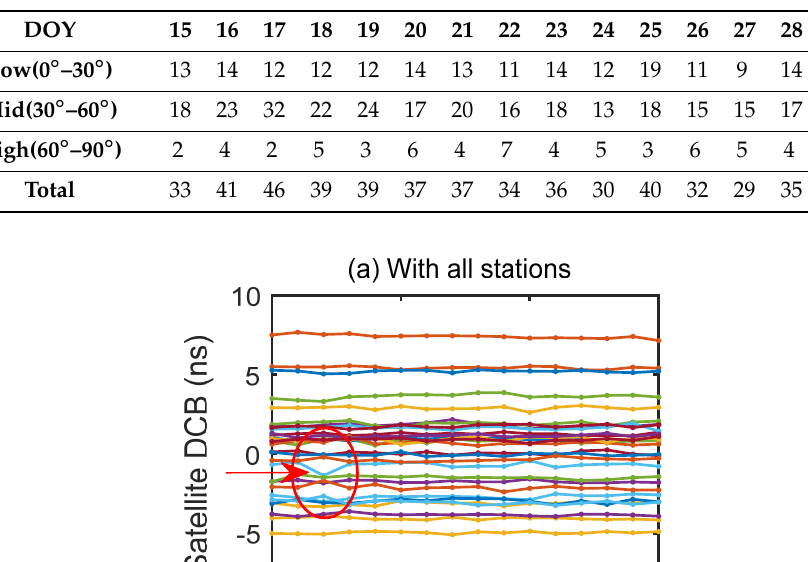
Table 1. Numbers of discarded stations located in low, mid and high latitudes during the second half of January 2011.